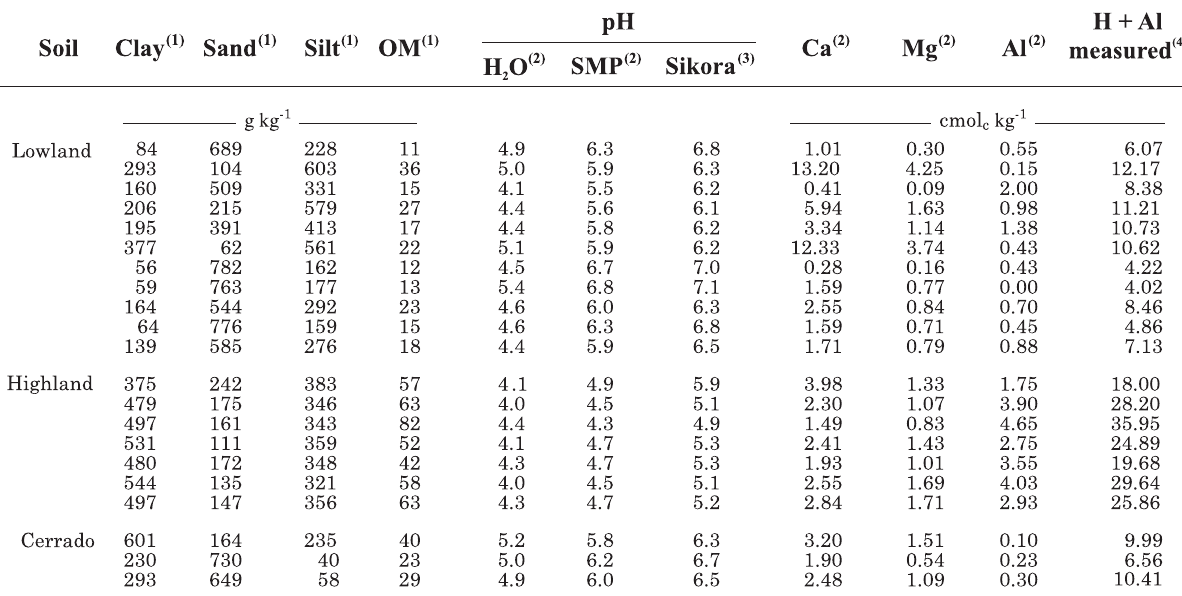
Table 1. General characteristics of unlimed